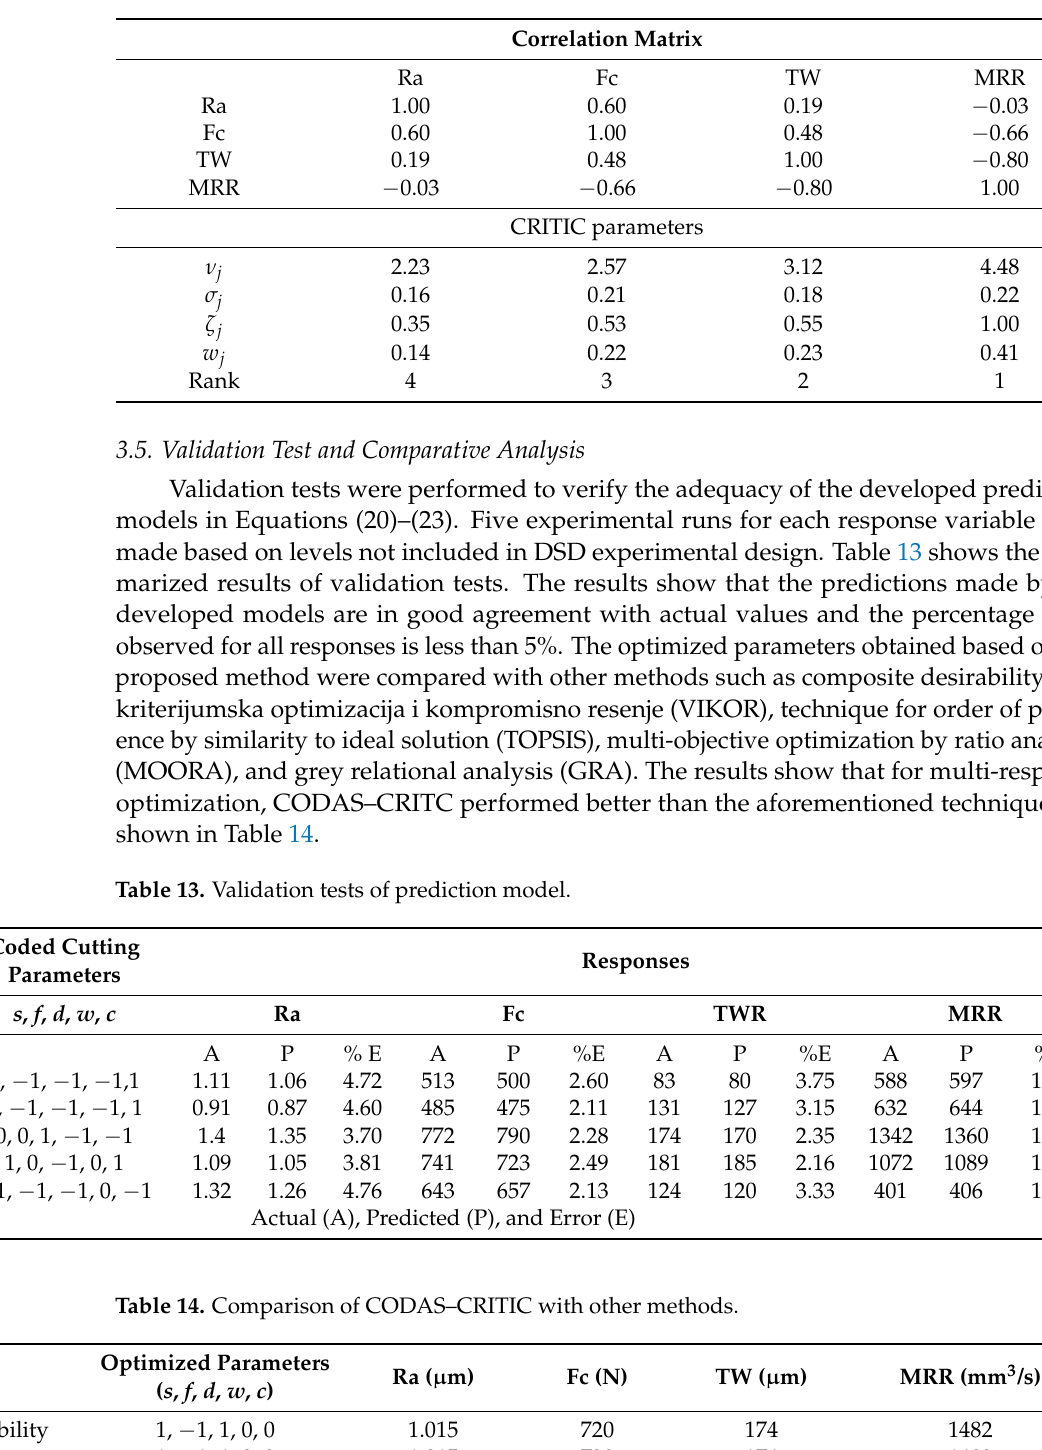
Table 12. Correlation matrix and weight determination of responses based on CRITIC.